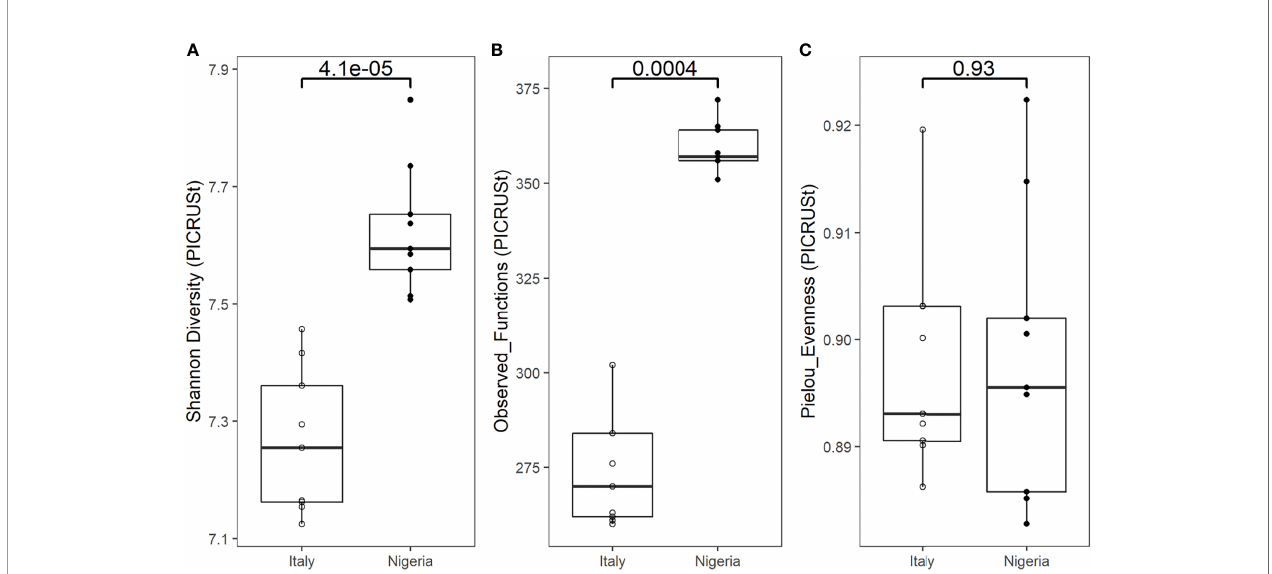
FIGURE 4 | Functional alpha diversity of an individual ’ s gut microbiota during the stay in Italy, and back to Nigeria. Boxplots show a signi fi cantly higher Shannon diversity (A) and number of observed functions (B) in the faecal microbiota of samples collected from Nigeria (n=9) compared to Italy (n=9) (p = 0.000041 and p = 0.00044, respectively). No difference in Pielou ’ s evenness (C) was observed (p = 0.93). Statistical test: Wilcoxon rank sum